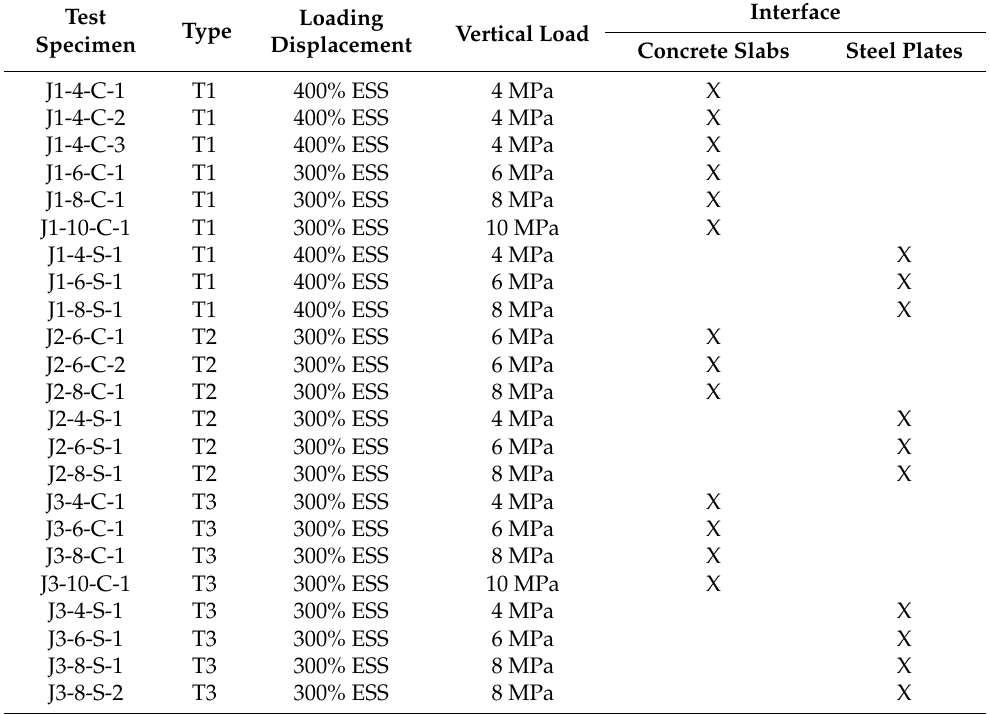
Table 2. Test program of LRBs.